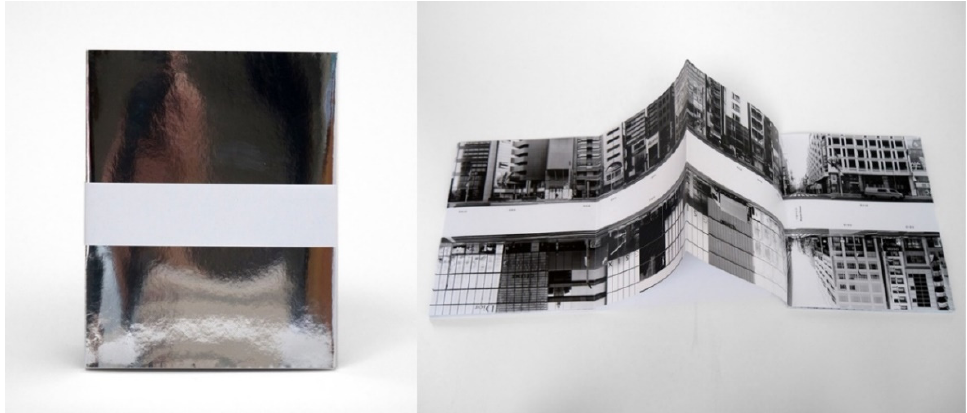
Figure 28. Michalis Pichler, Ginza Haccho / Every Building On The Ginza Strip, 2018.